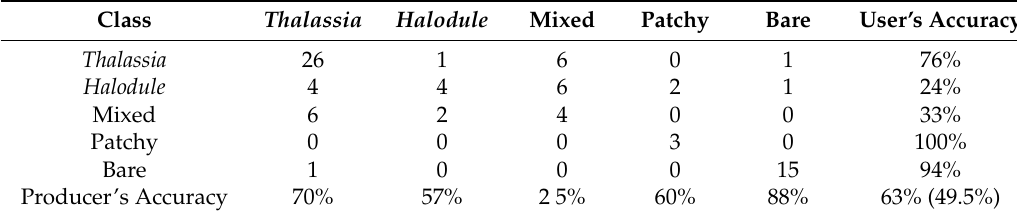
Table 3. Accuracy Matrix of the 5-class classification.